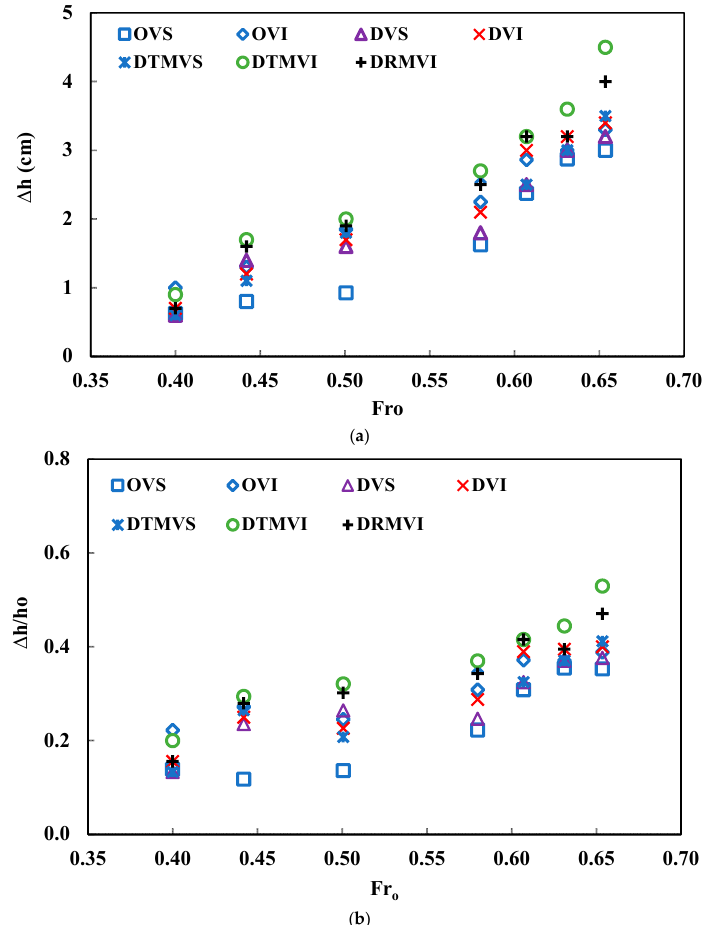
Figure 5. ( a ) Backwater rise ( Δ h ) of single defense system (SDS) and HDS, ( b ) relative backwater rise ( Δ h / h o ) of SDS and HDS.